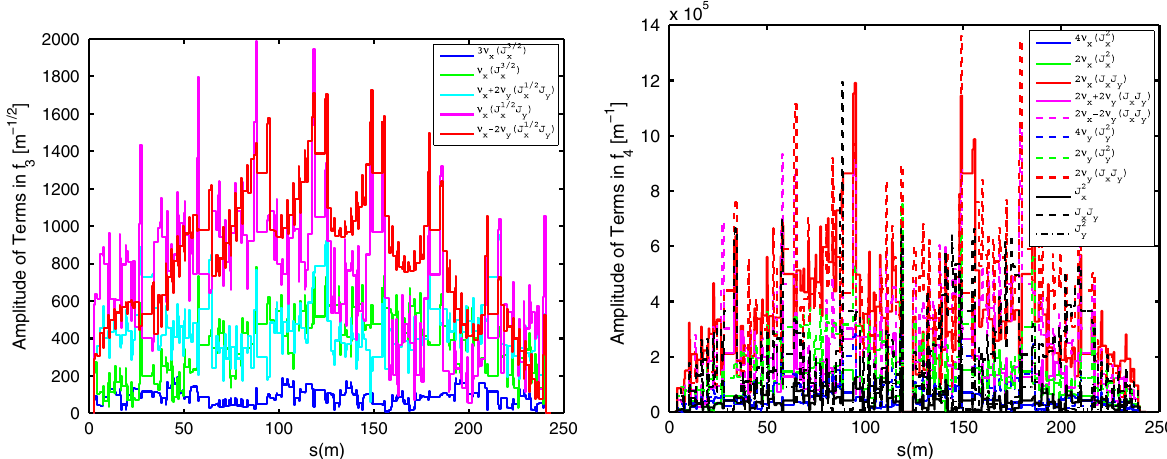
(left) and all 4th-order resonance as well as three tune shift terms in f 3